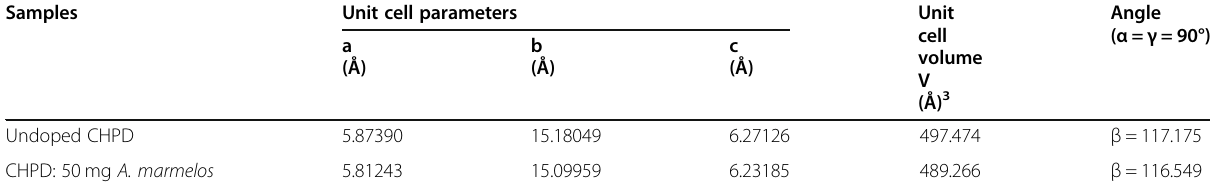
Table 2 Unit cell parameters, Unit cell volume (V) and Angle ( β ) for undoped and A. marmelos added CHPD crystals Samples